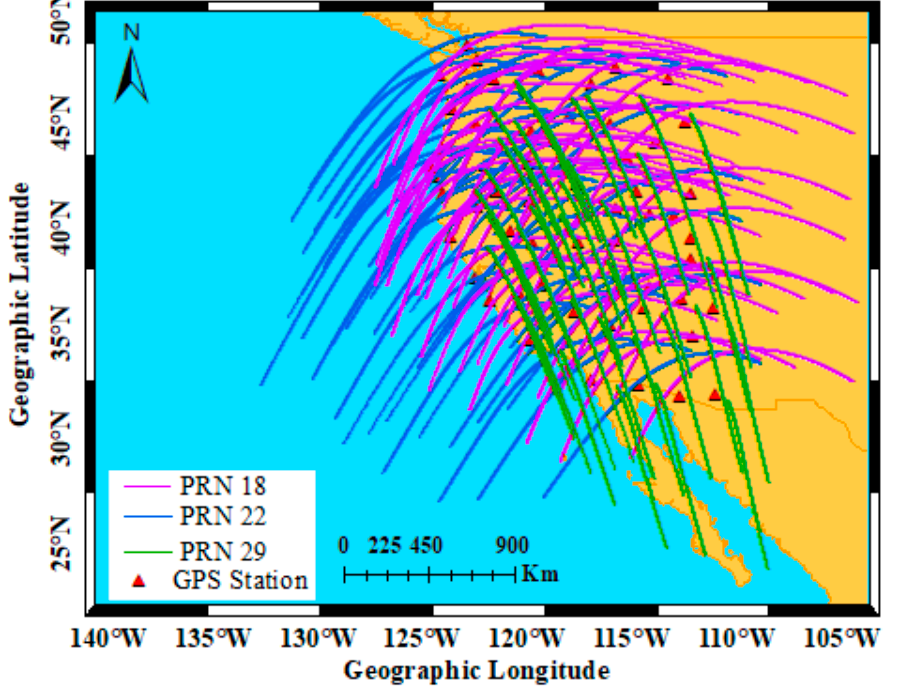
Figure 7. Location of IPPs for PRN 18 (purple line), PRN 22 (blue line), and PRN 29 (green line) observed from all the GPS stations from 15:10 UT to 20:00 UT on 11 March.